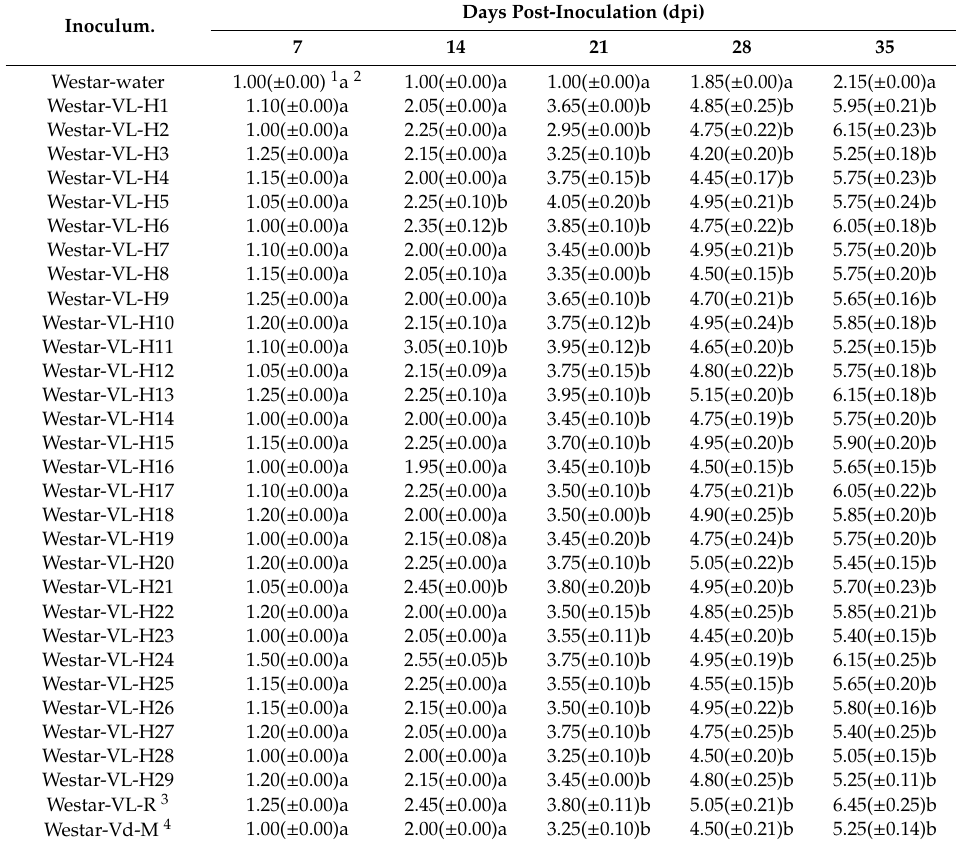
Table 1. Mean disease scores on B. napus susceptible cv. ‘Westar’ plants inoculated with Verticillium isolates compared to ‘Westar’ inoculated with water.